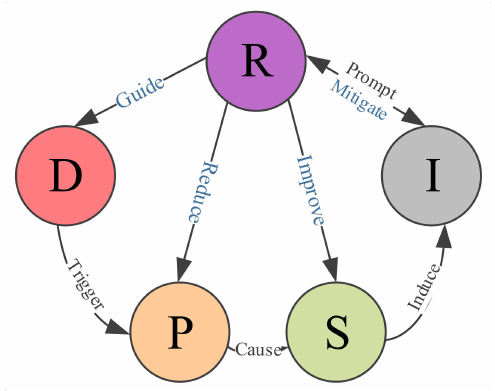
Figure 1. Driver Pressure–State–Impact-Response (DPSIR) model Schematic